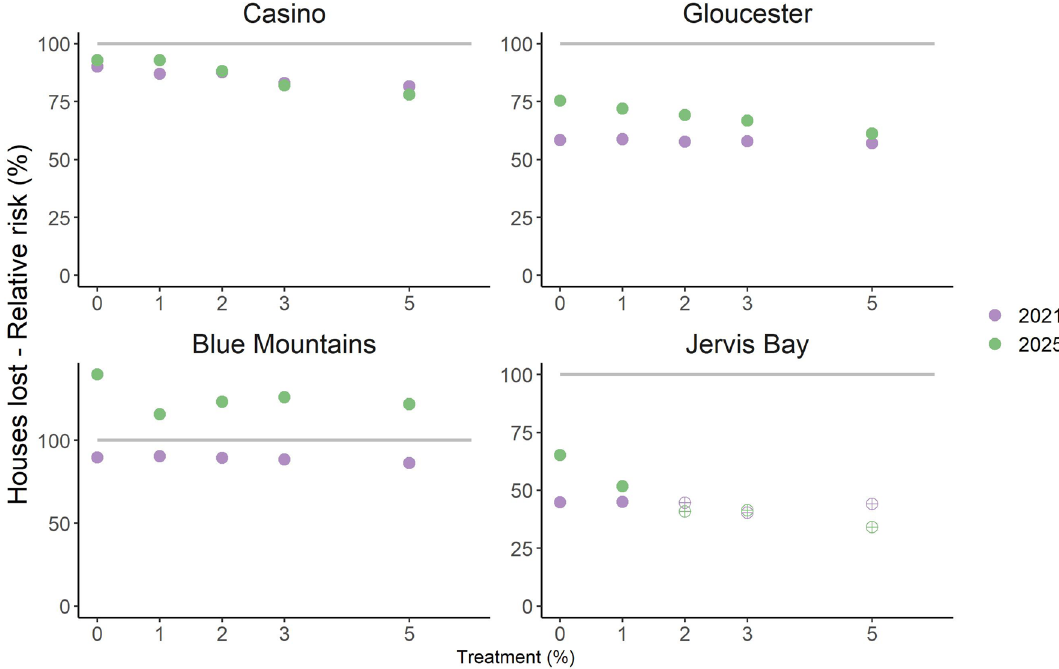
Figure 6.. Future residual risk trajectory of houses lost due to wildfire in the Casino, Gloucester, Blue Mountains and Jervis Bay case study areas. Risk is relative to a control scenario with pre-2019–2020 fuel load and no prescribed burning (the 100% level on the y-axis, indicated by line). Markers represent different annual treatment rates, colour indicates time period (blue = 2021 i.e. two years after 2019–2020 fire season, orange = 2025 i.e. six years after 2019–2020 fire season). In Jervis Bay the markers for 2, 3 and 5% p.a. treatment reflect edge treatment rates, with landscape treatment capped at 1% p.a. due to the very large area burnt during the 2019–2020 season (81% of the study area). Area (ha) (% burnt Case study landscape in 2019–2020) Elevation